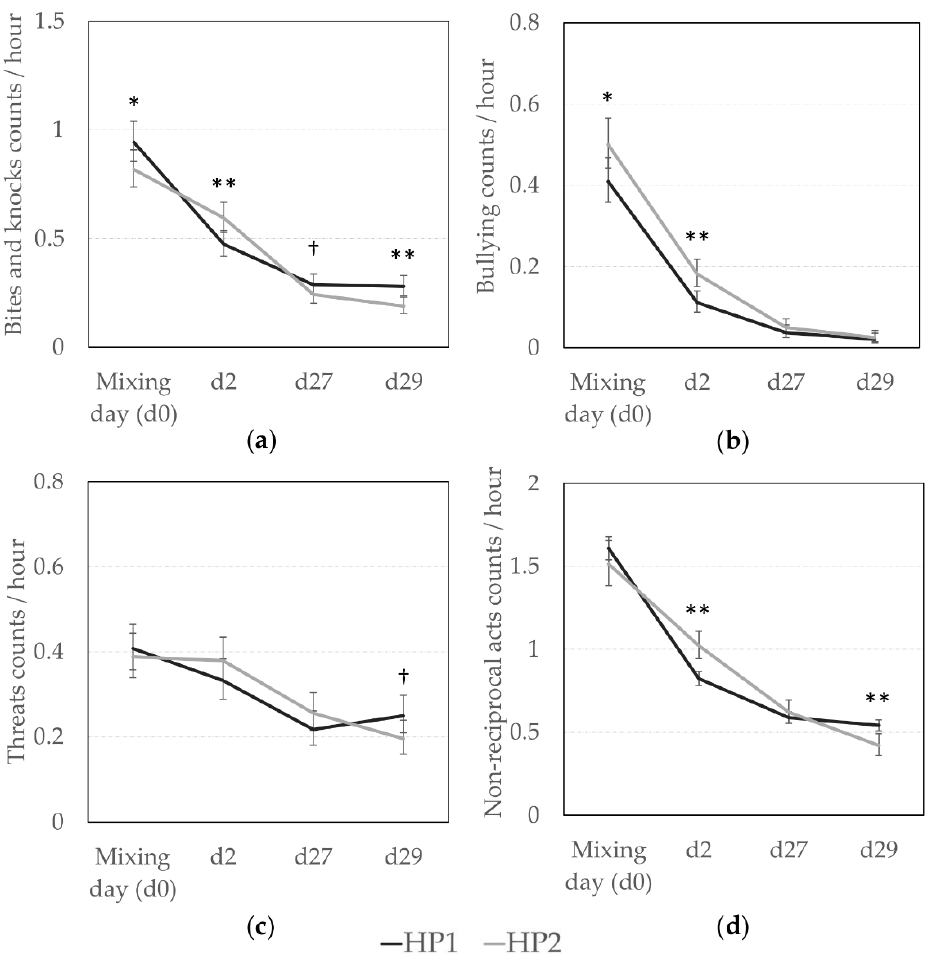
Figure 1. Non-reciprocal agonistic behaviors according to the genetic line (HP1, HP2). Back-transformed predicted mean (CI) number of ( a ) bites and knocks, ( b ) bullying, ( c ) threats, ( d ) total non-reciprocal acts (bites, knocks, bullying, and threats) given per hour at d0 (mixing), d2, d27, and d29. *, **; Means di ff er significantly (* p < 0.050, ** p < 0.010); † Means tend to di ff er ( p < 0.10) between genetic lines for a same observation day.